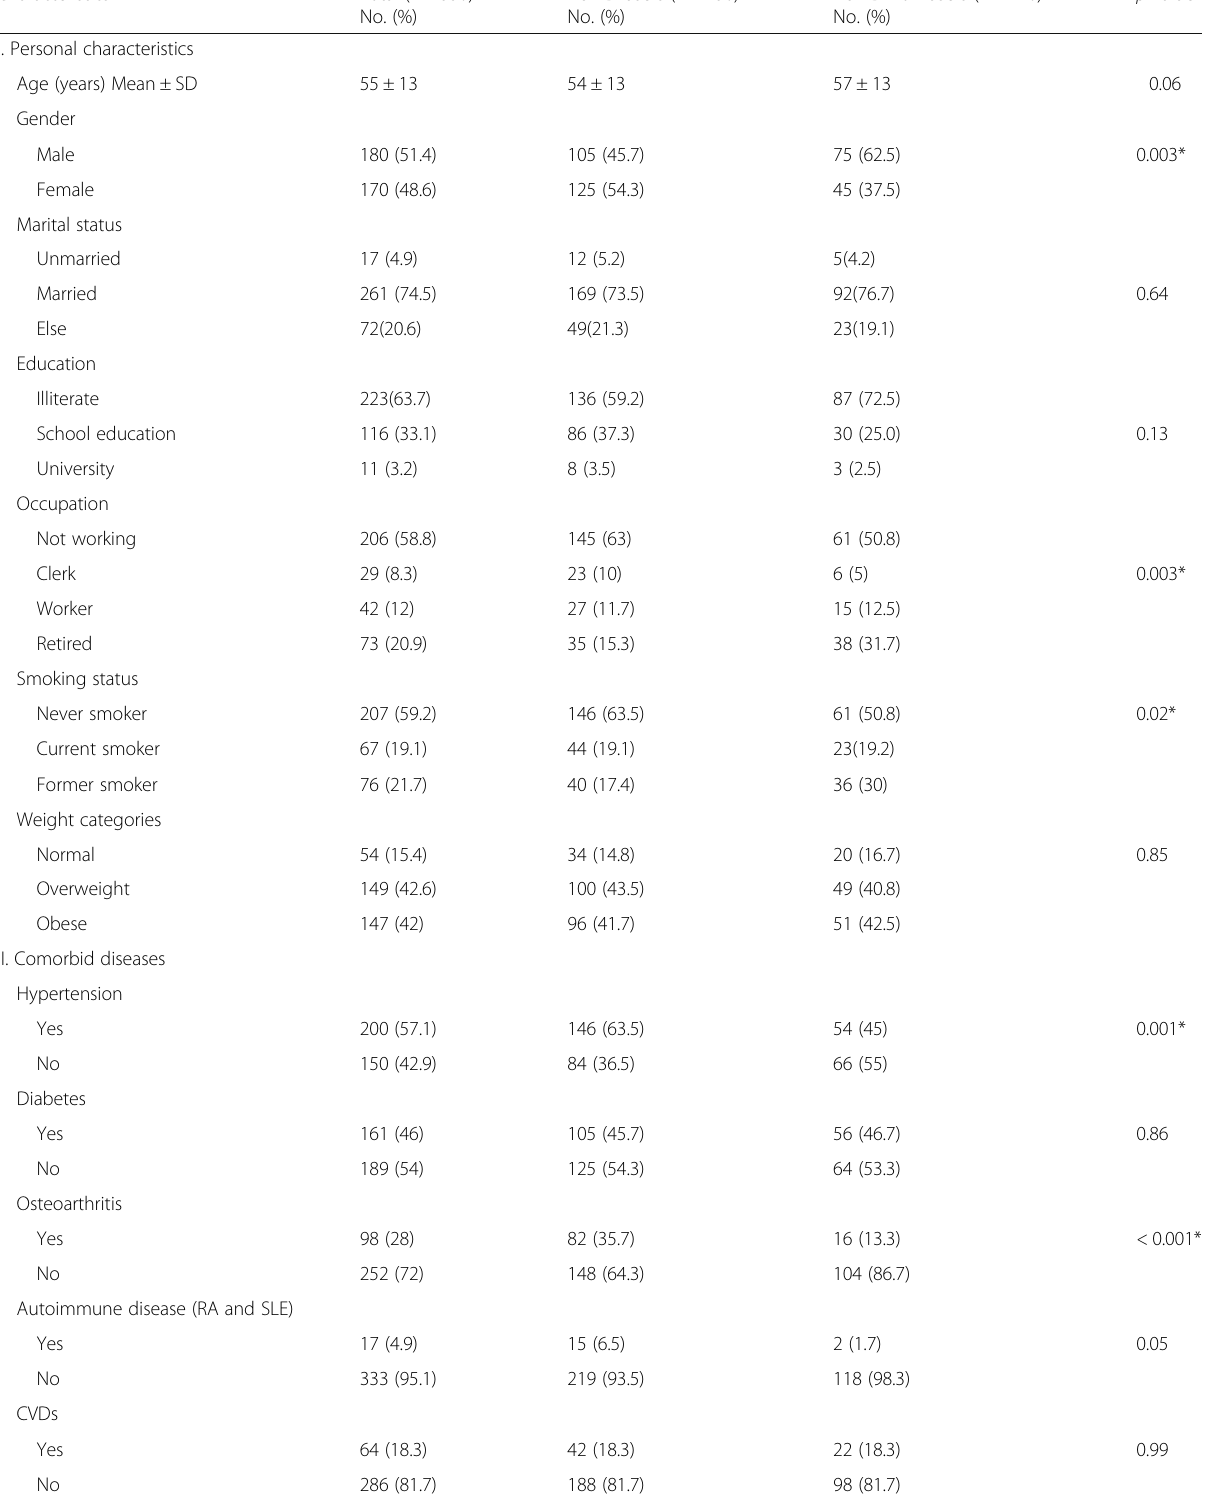
Table 1 Characteristics of the study CKD patients, Alexandria Main University Hospital, Egypt, 2016